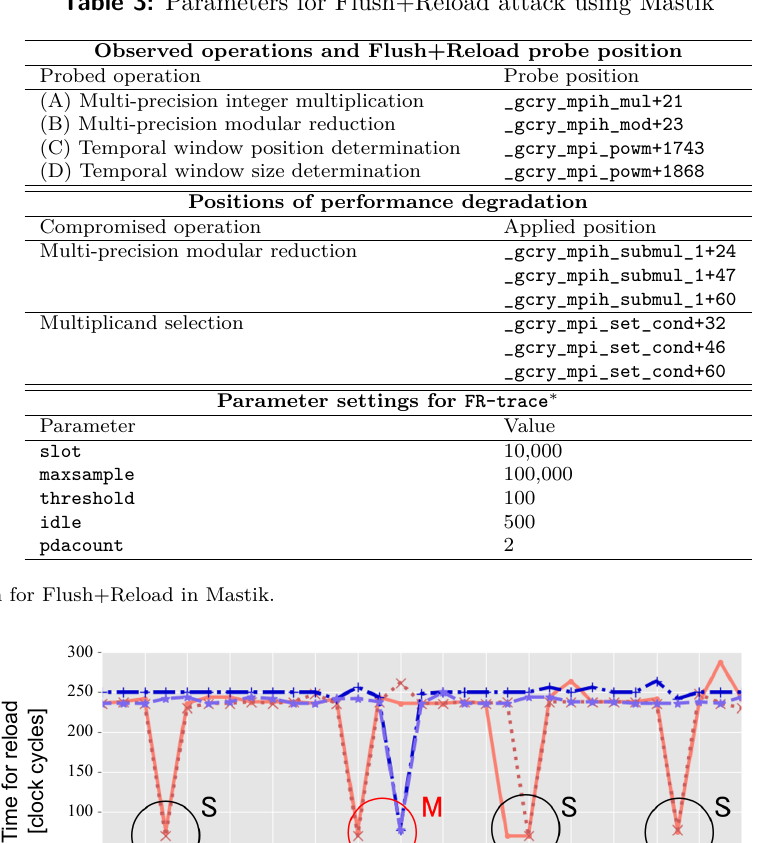
Table 3: Parameters for Flush+Reload attack using Mastik